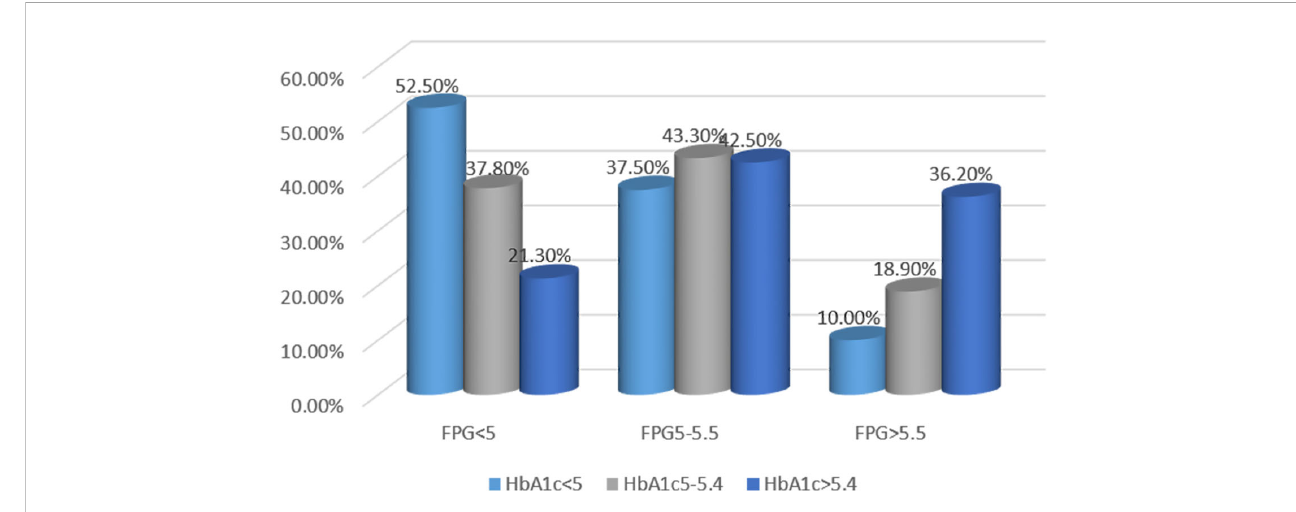
FIGURE 2 Distribution of HbA1c value at different FPG